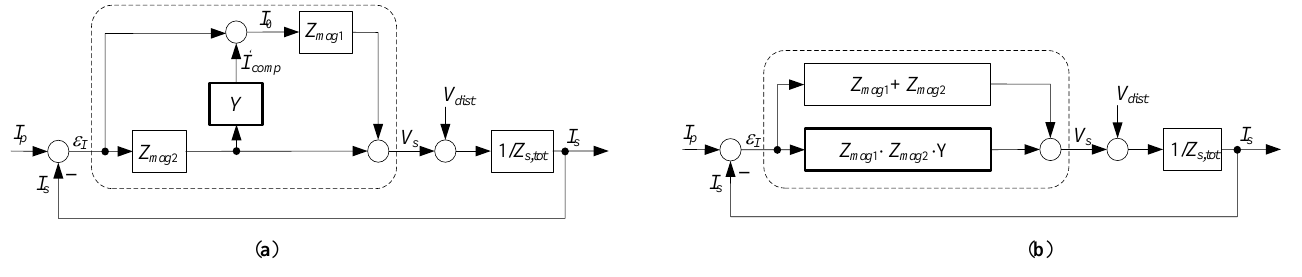
Figure 4. EECT’s functional diagram: ( a ) drawn in accordance with (2), (3) and (4); ( b ) rearranged.